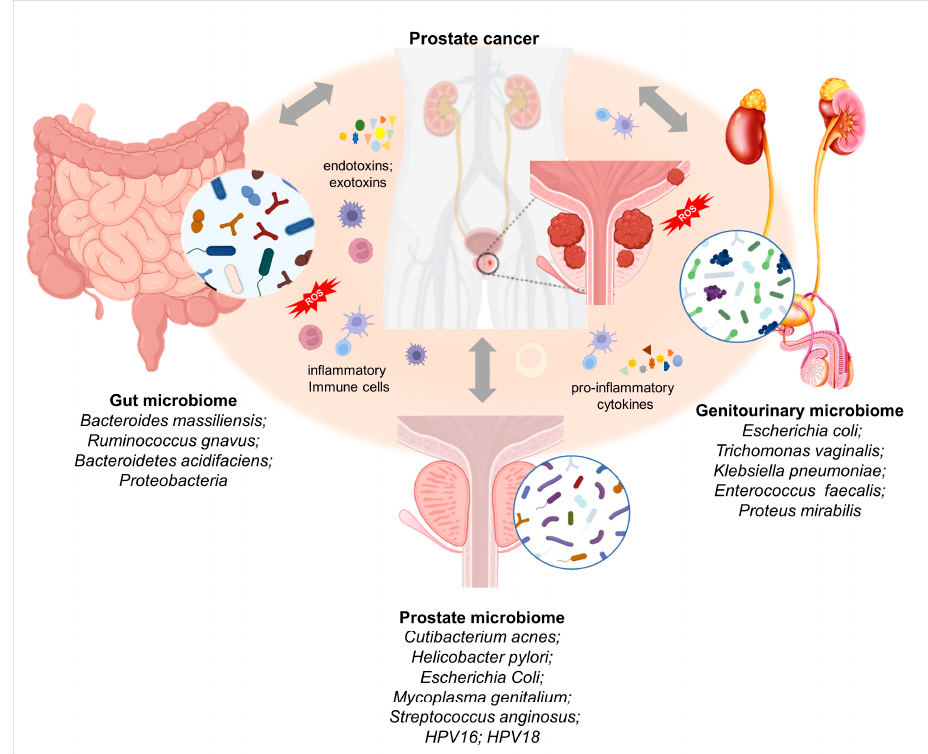
Figure 1. Gut, intraprostatic and genitourinary microbiomes and their association with prostate cancer (PCa) insurgence and progression. Image created using Biorender.com.